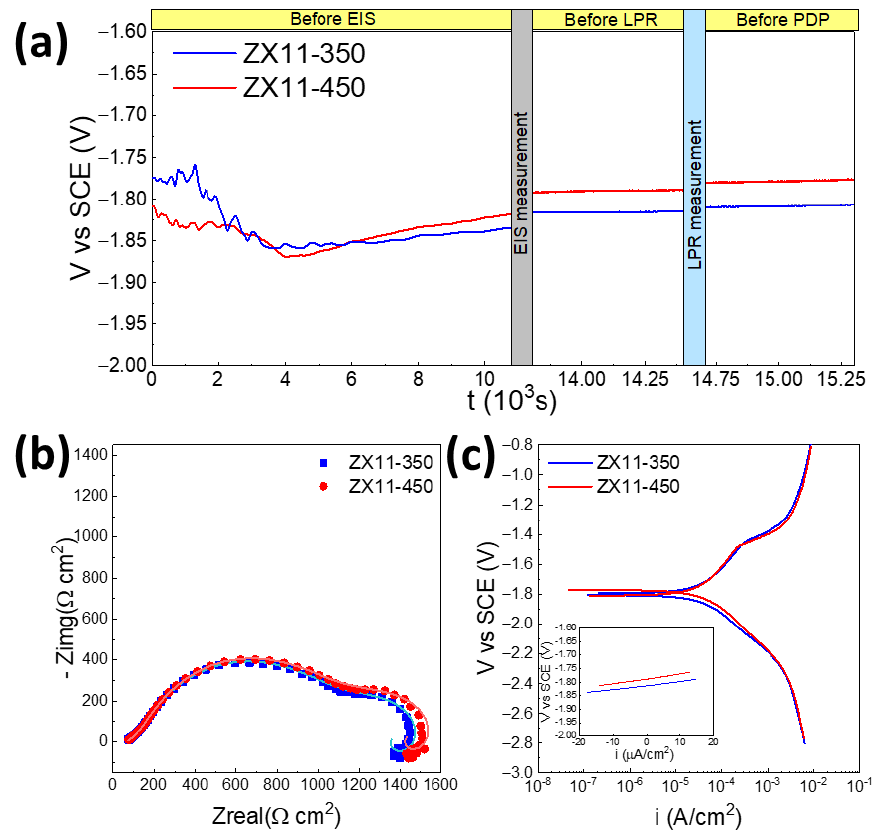
Figure 3. Representative OCP ( a ), Nyquist ( b ) and PDP plots ( c ) of ZX11-350 and ZX11-450 samples immersed in DMEM /F-12 + 10% v / v FBS. The symbols in ( b ) correspond to the experimental data and the lines to the fitting for the EIS data. All the experiments were conducted in triplicate, observing good reproducibility.